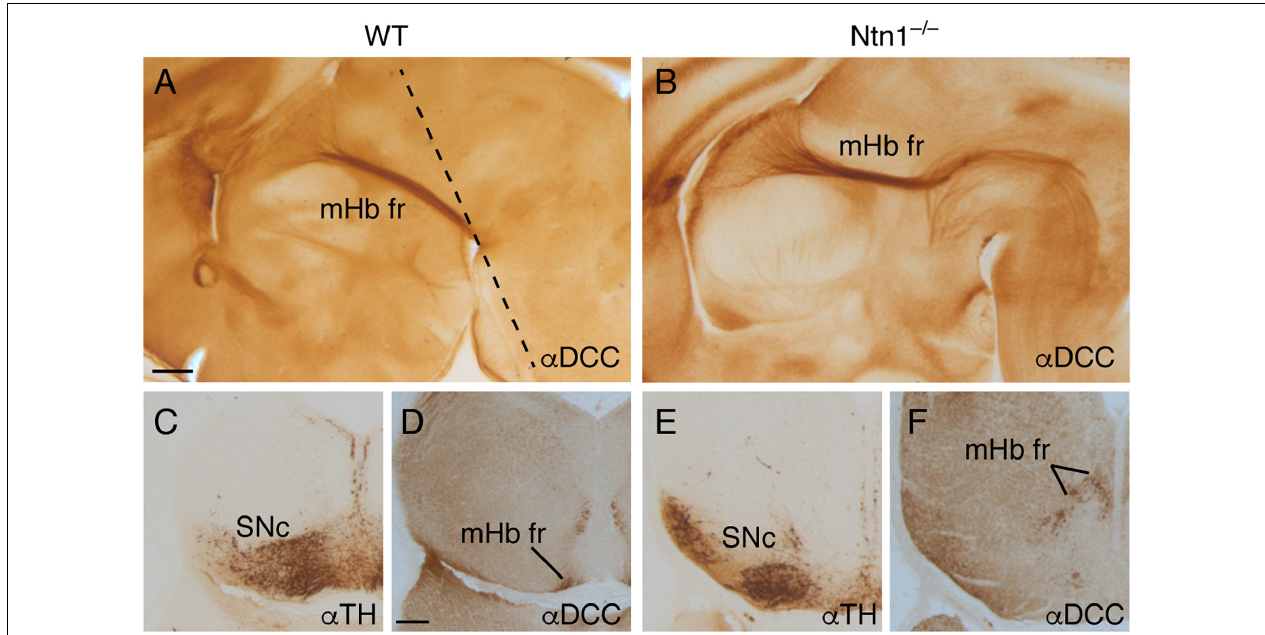
FIGURE 7 | The fr phenotype in Ntn1 − / − . Sagittal section of E16.5 wild-type (A) and Ntn1 − / − (B) brains stained with α DCC. The mHb fr in the mutant displayed an abnormal trajectory; a bunch of these fibers followed the normal path until the basal plate. At that point, they bended caudally toward caudal positions. The dotted line in A indicates the section plane in C–F . Coronal sections of a E16.5 wild type (C,D) and Ntn1 − / − (E,F) labeled for TH and DCC. In the mutant, the SNc presented an abnormal distribution, and the mHb fr was defasciculated and occupied a dorsal position. Abbreviations: mHb fr, medial habenular axons of the fasciculus retroflexus; SNc, substantia nigra pars compacta. Scale bar: 200 µ